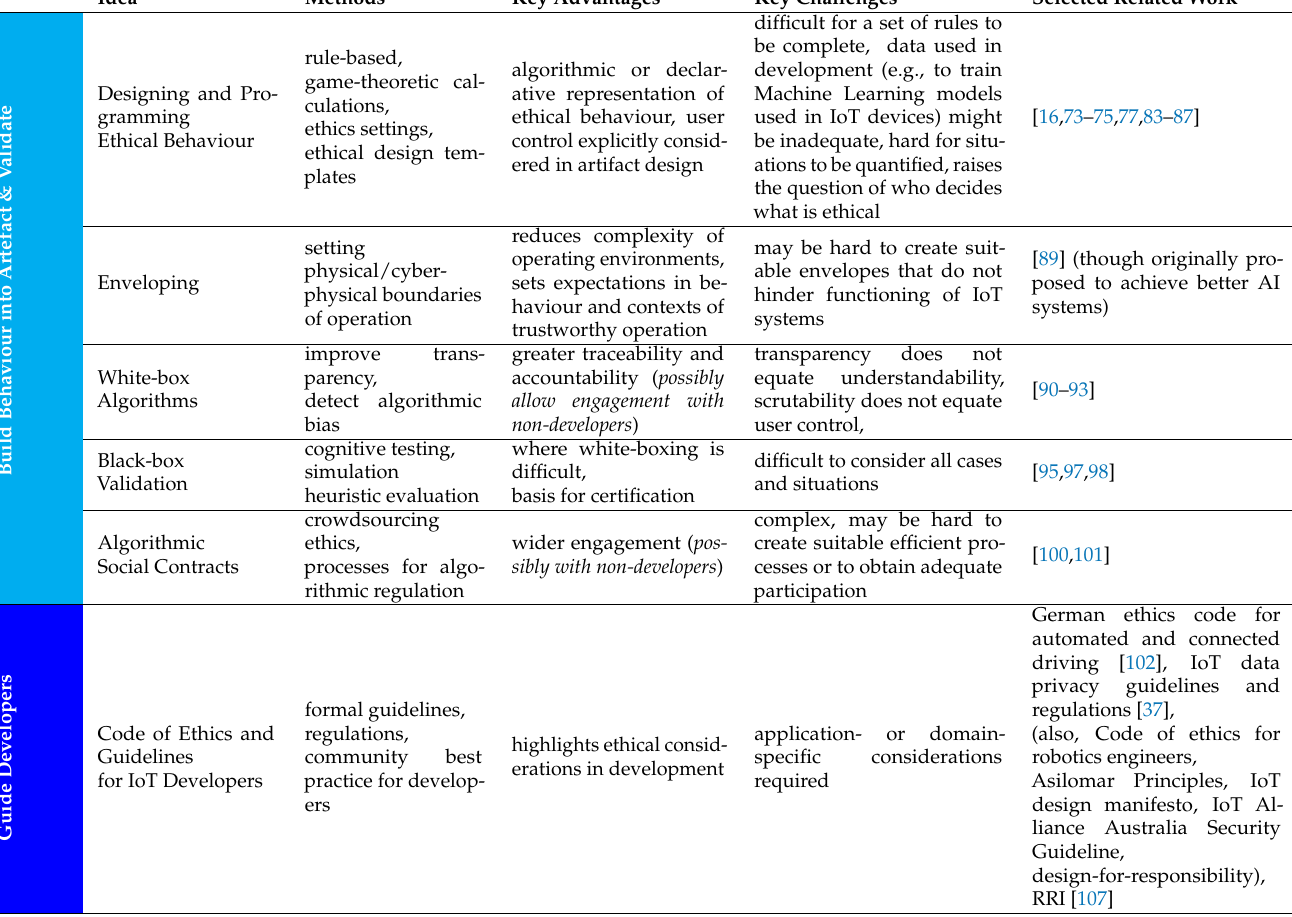
Table 1. Summary of ideas to achieve ethical algorithmic behaviour in the IoT with key advantages and